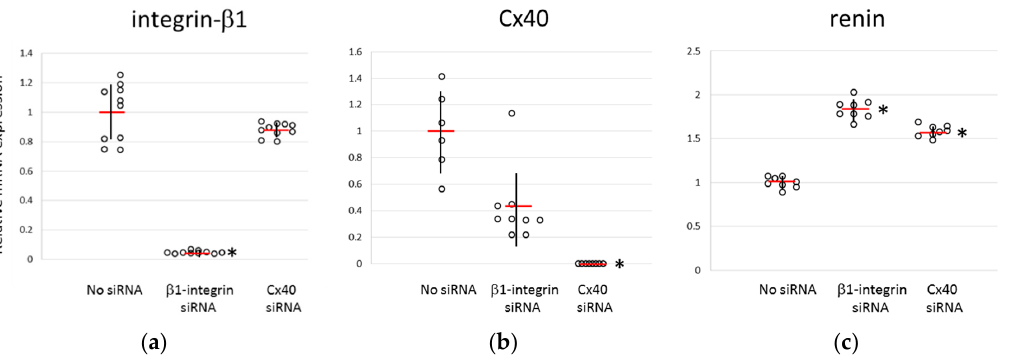
Figure 2. Effects of knockdown of β 1-integrin or Cx40 on the renin expression in a juxtaglomerular cell line (As4.1 cells). Gene knockdown was performed by culturing As4.1 cells with siRNA for β 1-integrin or siRNA for Cx40 for 24 h. Vehicle was added to the control culture (no siRNA). The expression of β 1-integrin ( a ), CX40 ( b ) and renin ( c ) was quantitated by qRT-PCR. The expression relative to individual controls (no siRNA) is represented by scatter plot with the average (red bars) and SD (black vertical lines). Asterisks indicate a significant difference ( p < 0.05) from the control (no siRNA).